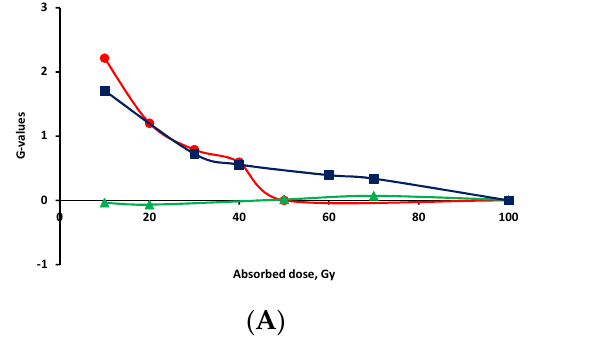
Figure 2. Efficiency of sertraline degradation and ionic products formation in aqueous solution saturated before irradiation with N 2 O- • OH radicals predominate: ( ● )-sertraline 1 mg/L degradation, ( ■ )-Cl − formation, (  )-NO 3 − formation, ( ♦ )-NO 2 −